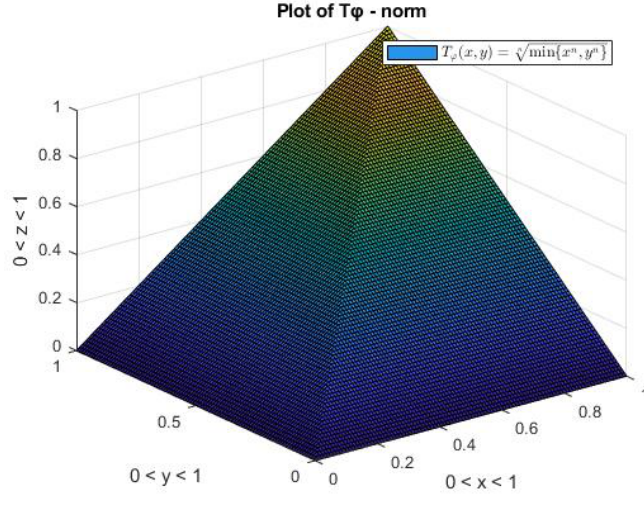
Figure 3. t-norm generated from T M using an automorphism